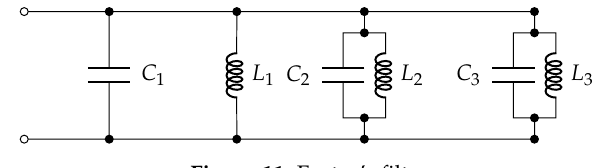
Figure 11. Foster’s filter.